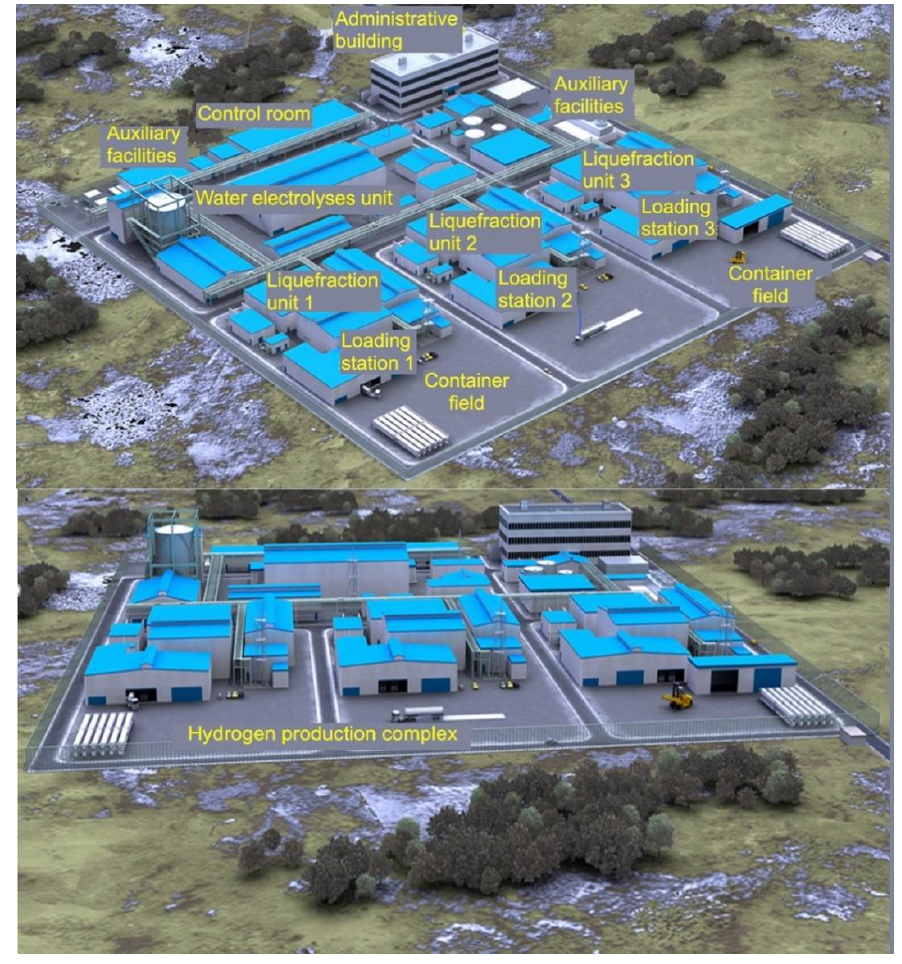
Figure 6. Planned hydrogen complex.